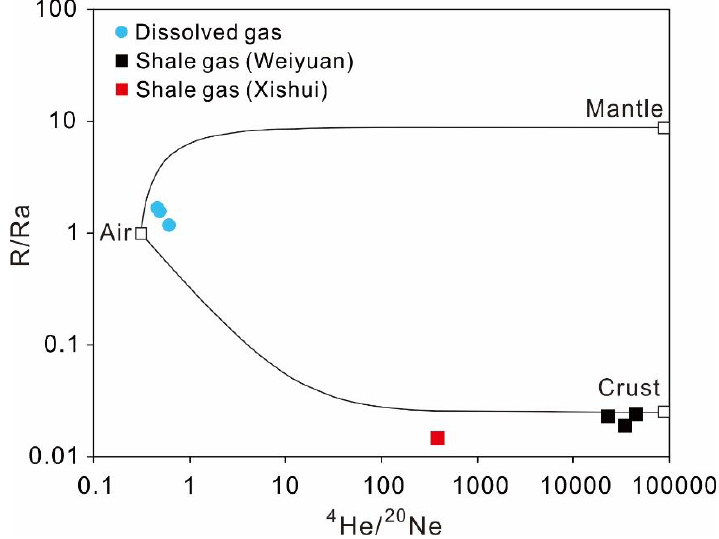
Figure 9. Diagram of R/Ra versus 4 He/ 20 Ne with dissolved gas in shallow groundwater and shale gas from Weiyuan and Xishui.